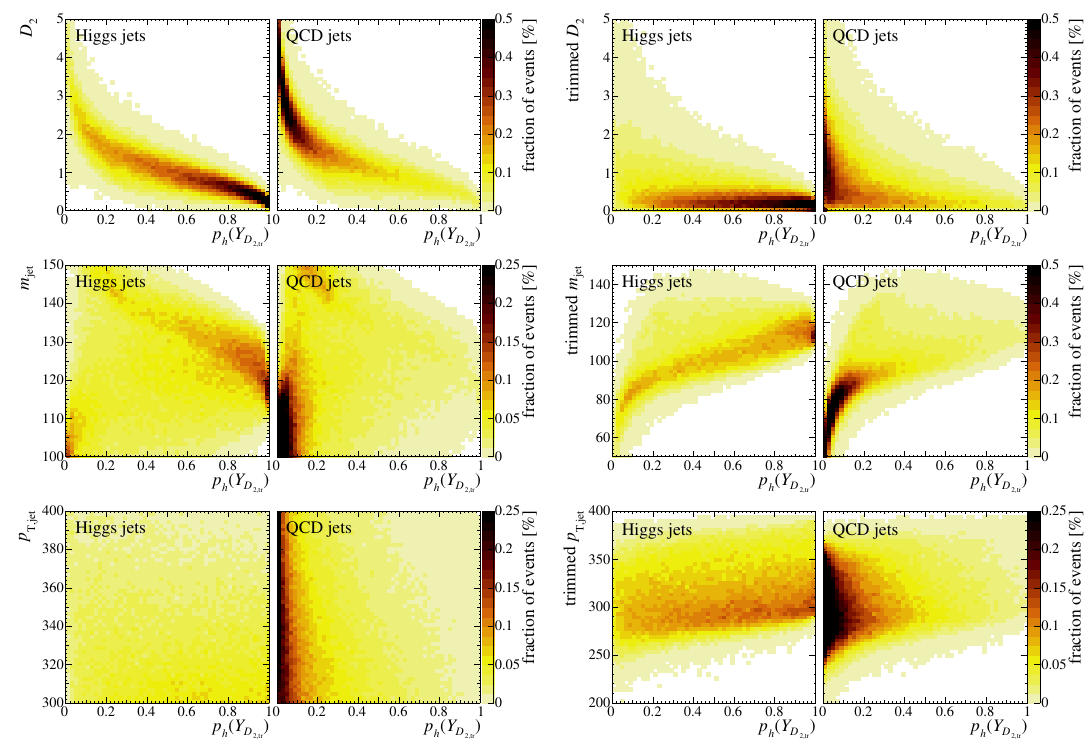
Figure 7 . The distributions of Higgs jets and QCD jets in the Higgs-like probability p h ( Y D and inputs in f x i g D planes. For each pair of (cid:12)gures, a left panel is the distribution of Higgs 2 + tr jets and a right panel is the distribution of QCD